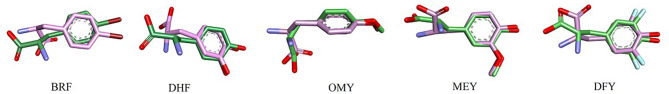
Structural alignment between crystal and MD stable structures of single UAAs in protein–ligand interactions. F and Br atoms from DFY and BRF are light blue and dark red, respectively. The colors of other atoms are the same as in Figure 4.